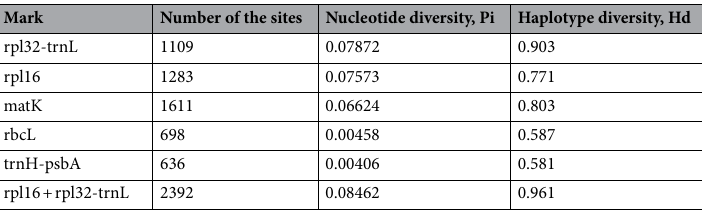
Table 3. Diversity information of DNA sites based on 66 bamboo